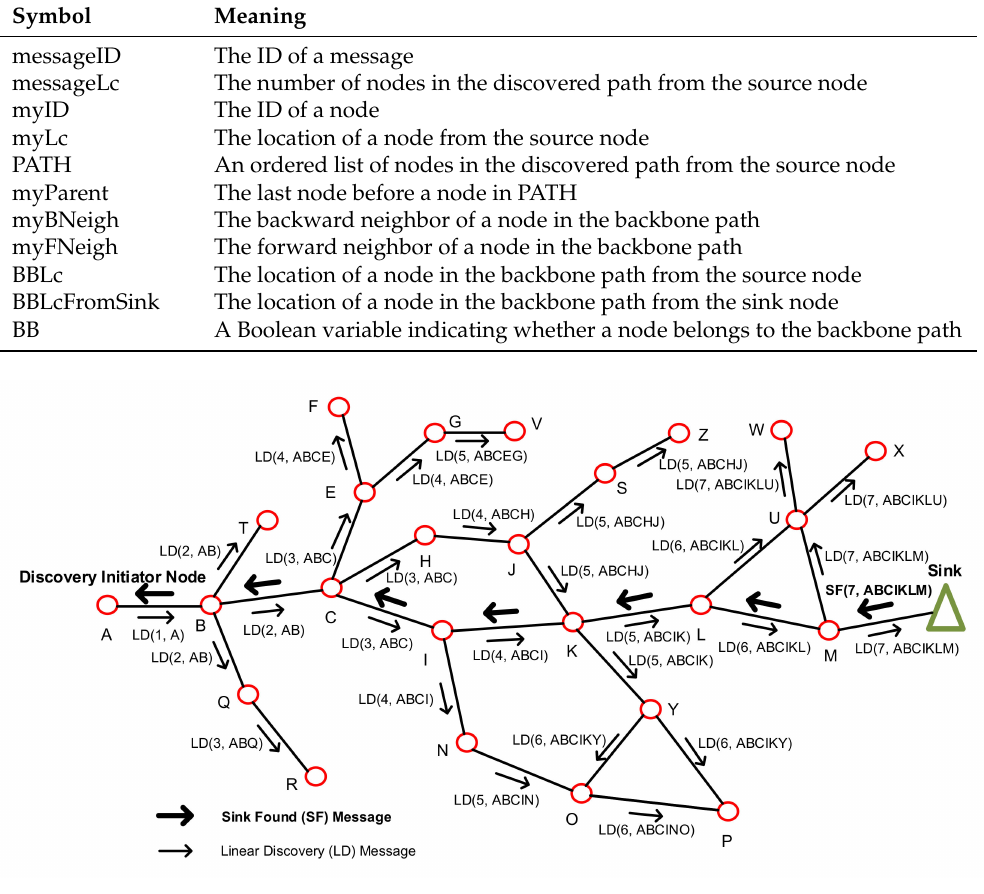
Figure 2. Propagation of an LD message in the LBD algorithm